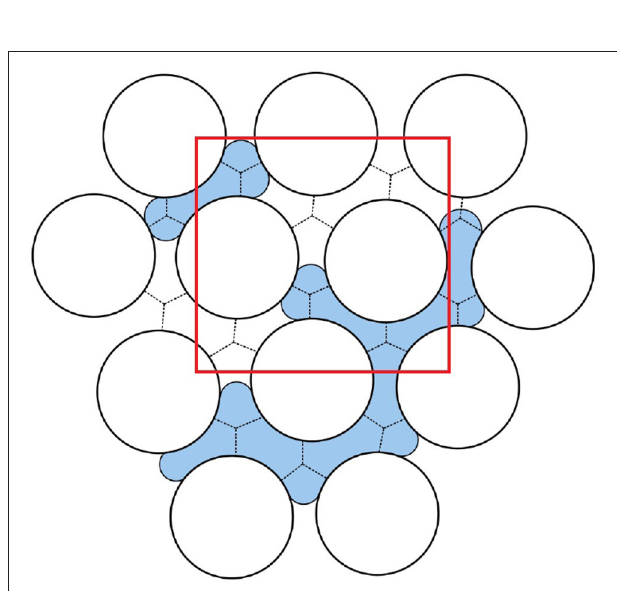
FIGURE 2 | A schematic collection of pores filled with two immiscible liquids. In order to compute the system properties, we define a REV. A REV is indicated in the figure by the red square. Courtesy of M.